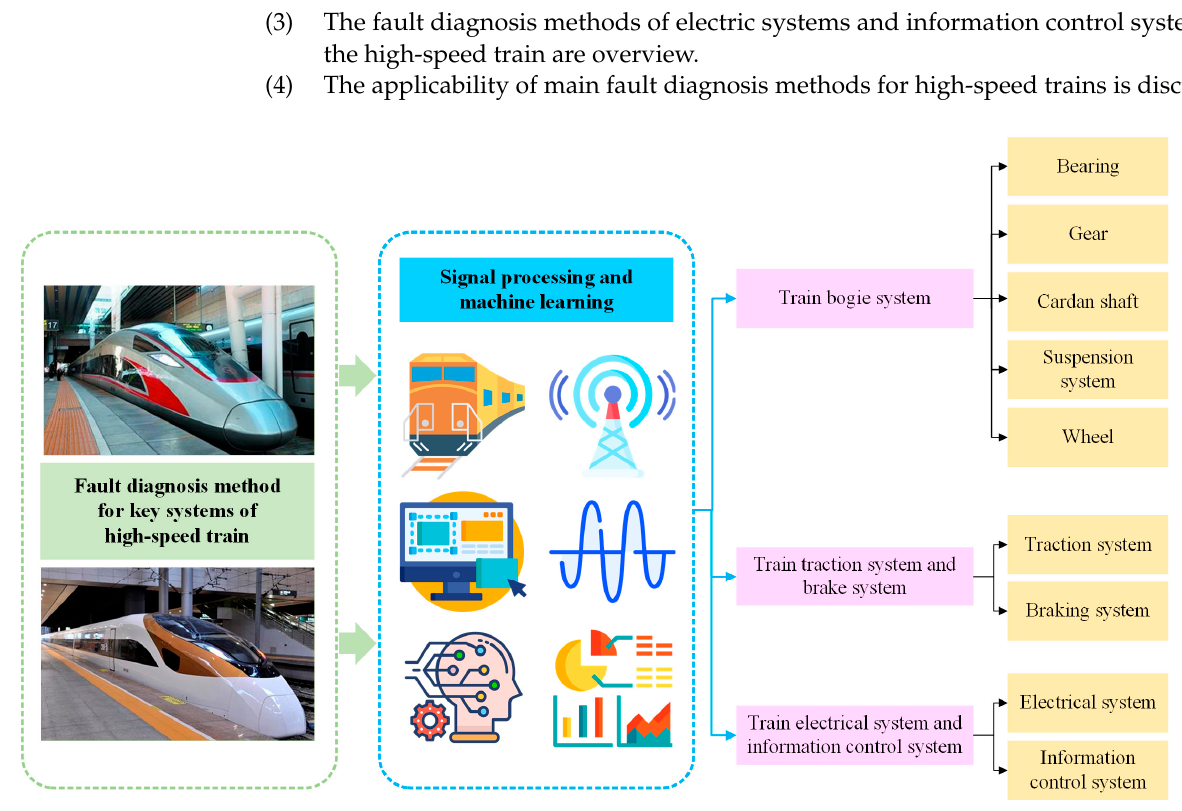
Figure 1. Fault diagnosis for key systems of high-speed